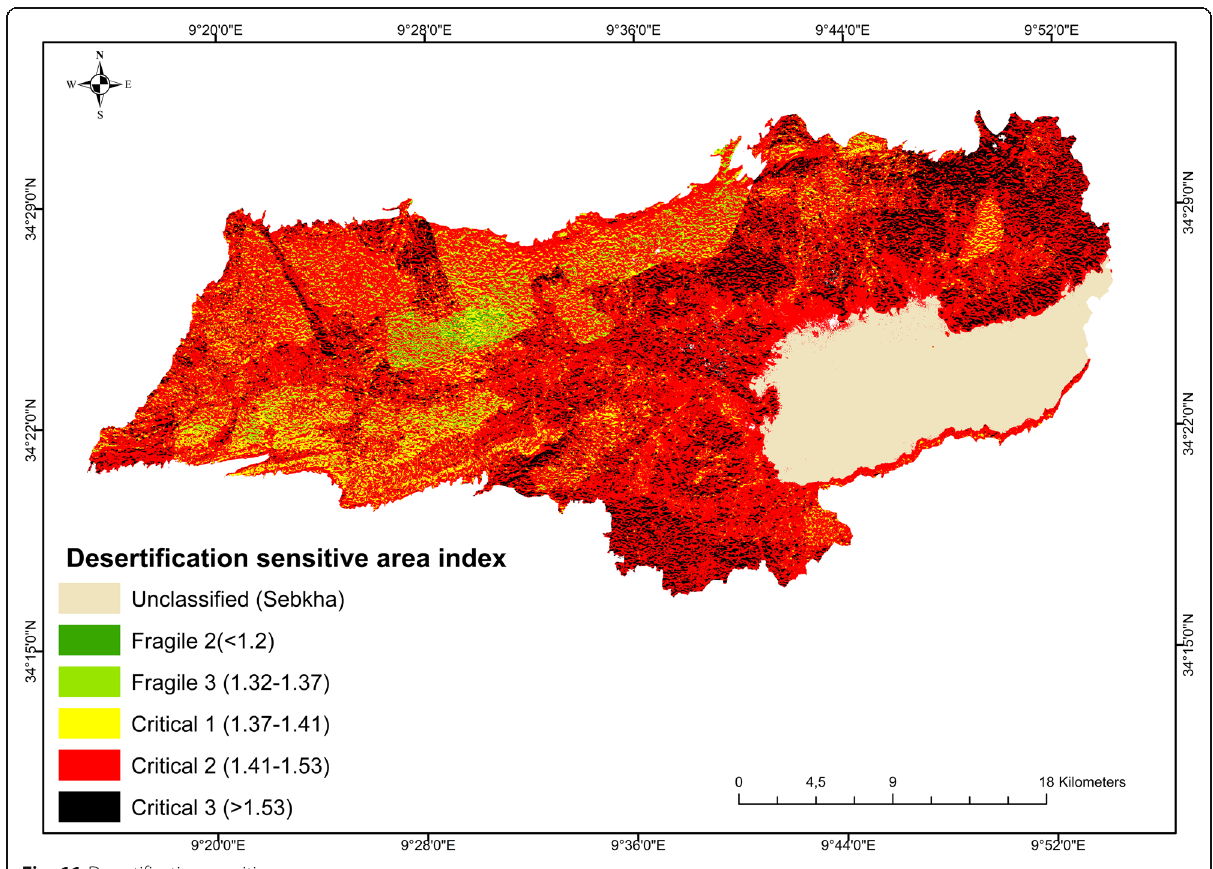
Fig. 11 Desertification sensitive areas